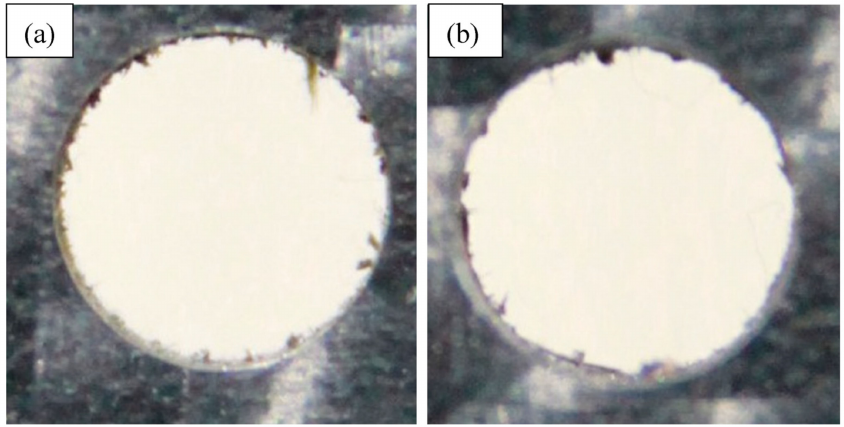
Figure 12. Drilled holes ( a ) with 3 layers of Scotch tape layer and ( b ) without Scotch tape